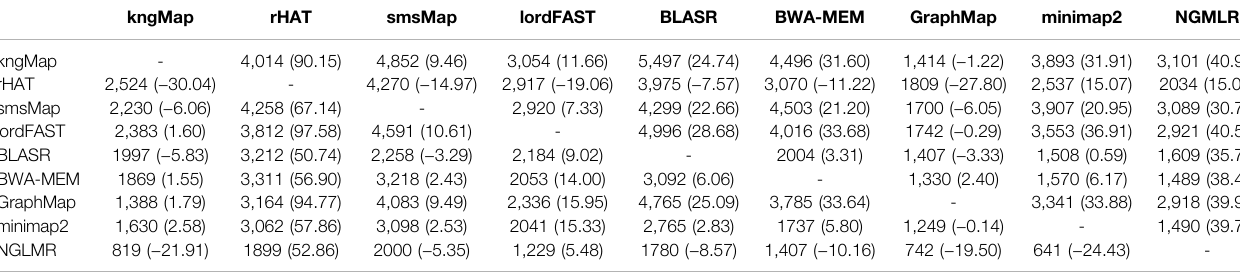
TABLE 5 | Performance of each pair methods on the A. thaliana dataset for which their alignments do not agree. kngMap rHAT smsMap lordFAST BLASR BWA-MEM GraphMap minimap2 NGMLR